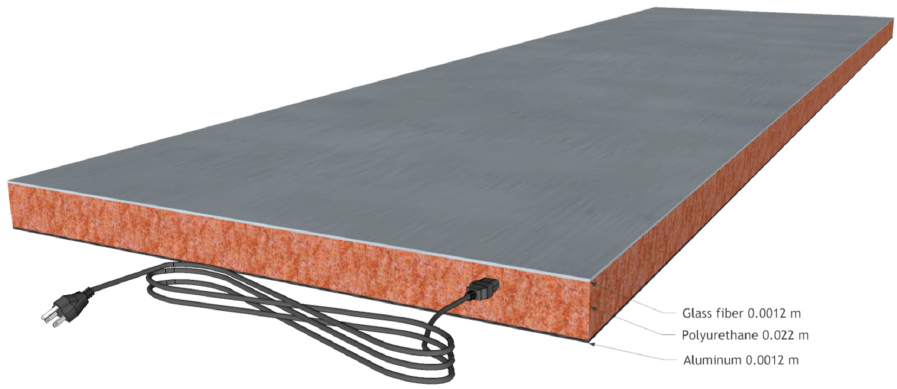
Figure 1. Sketch of the radiant panel. Table 1. Stratigraphy of the electric radiant panel.